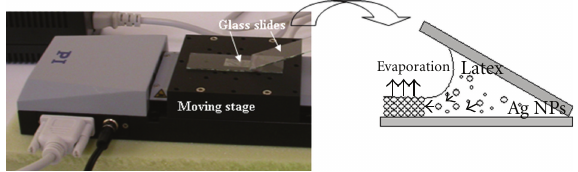
Figure 1: The “convective-assembly” setup used to construct the microwells in this